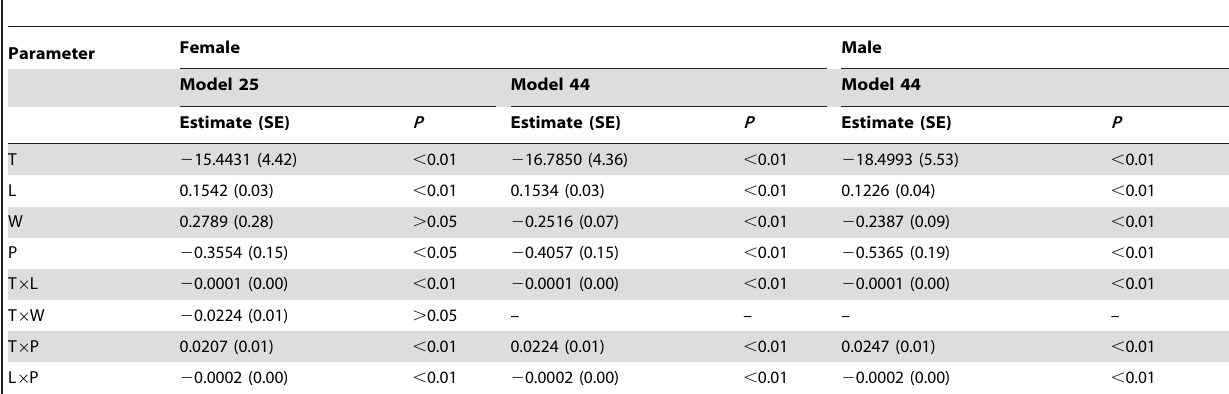
Table 2. Parameter ( b s) estimation of the best set of models predicting flight of Pityophthorus juglandis in response to ambient temperature (T), light intensity (L), wind speed (W), and barometric pressure (P) and some of their